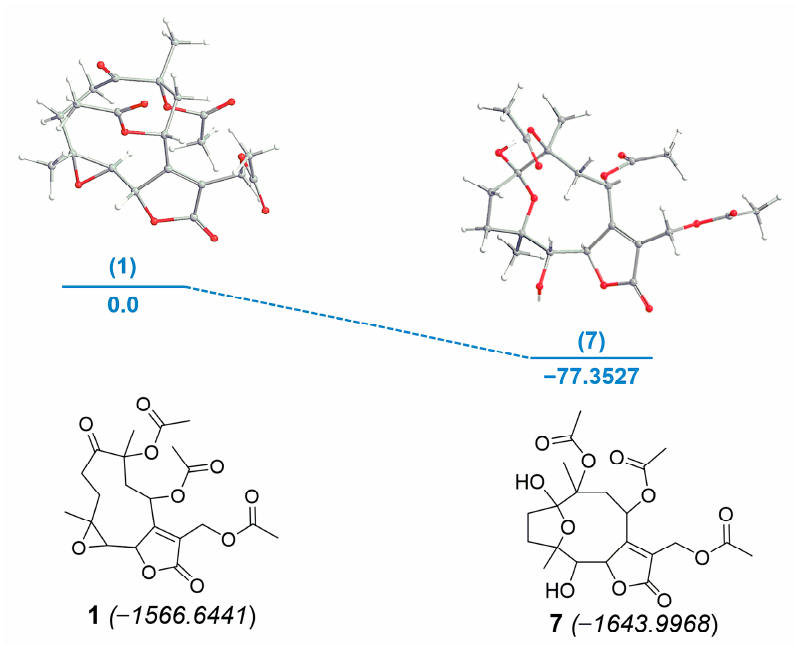
Figure 6. Energy diagram for the formation of SL semisynthetic derivative 7 from 1 . Relative energies [kcal/mol, B3LYP/6-31G*] (blue). Electronic energy values (italic) for compounds 1 and 7 are expressed in kcal/mol. Oxygens are represented as red atoms.